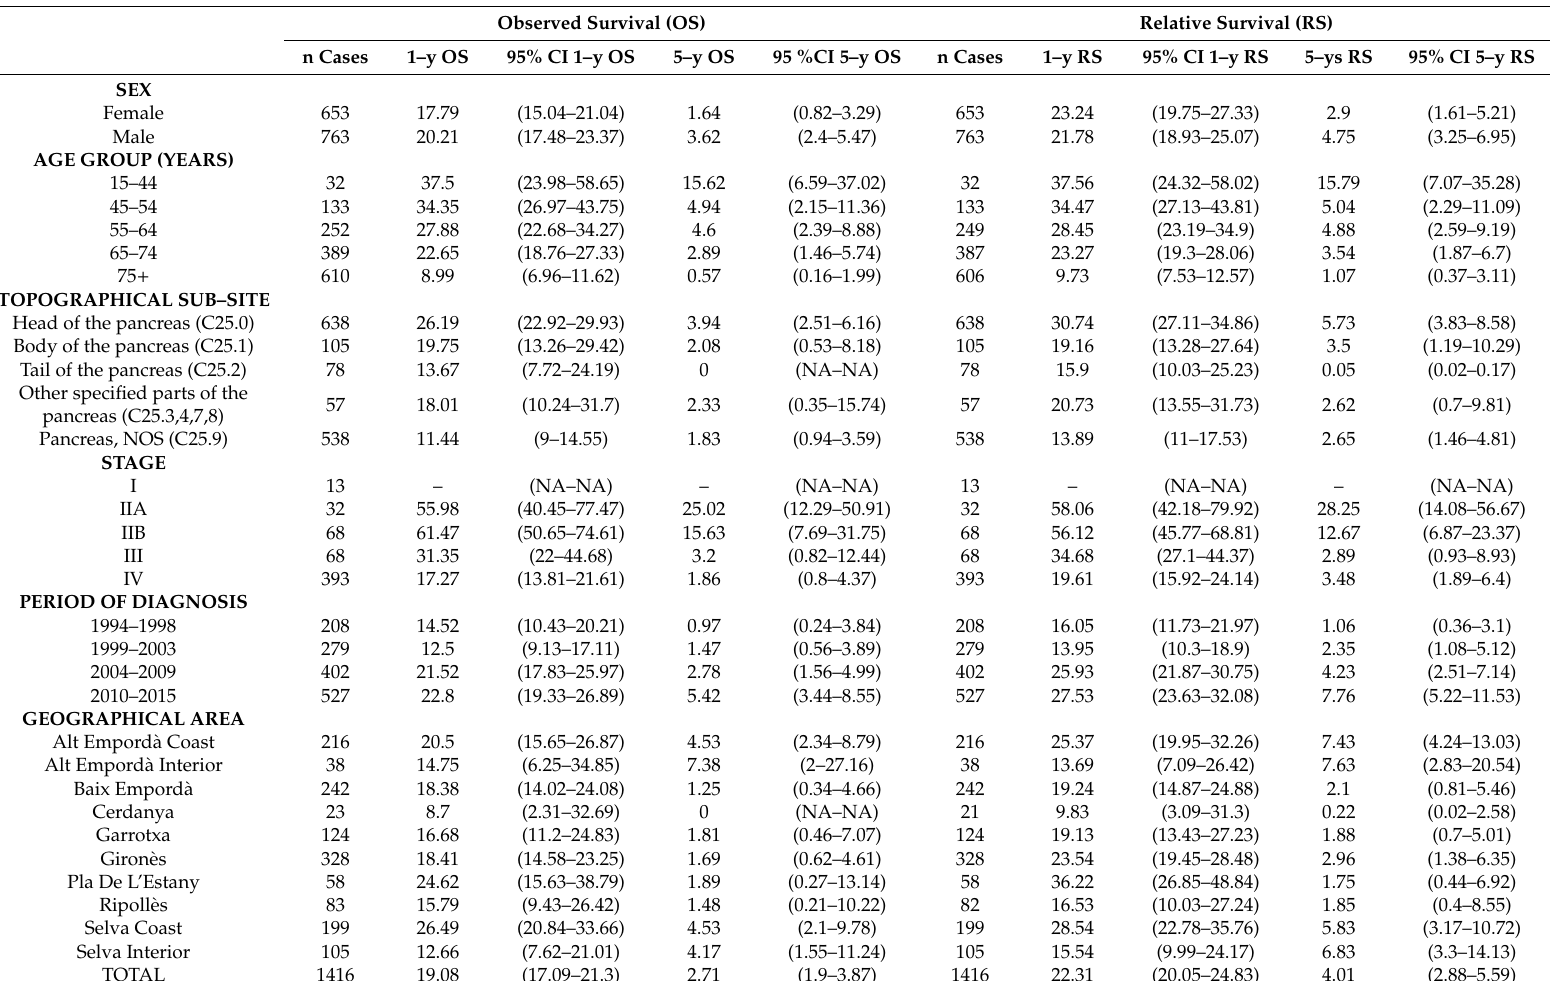
Table 4. One and 5-year observed and relative survival for non-PNETs and non-HC PC by sex, age, stage, period of diagnosis, sub-site and county. Girona province,